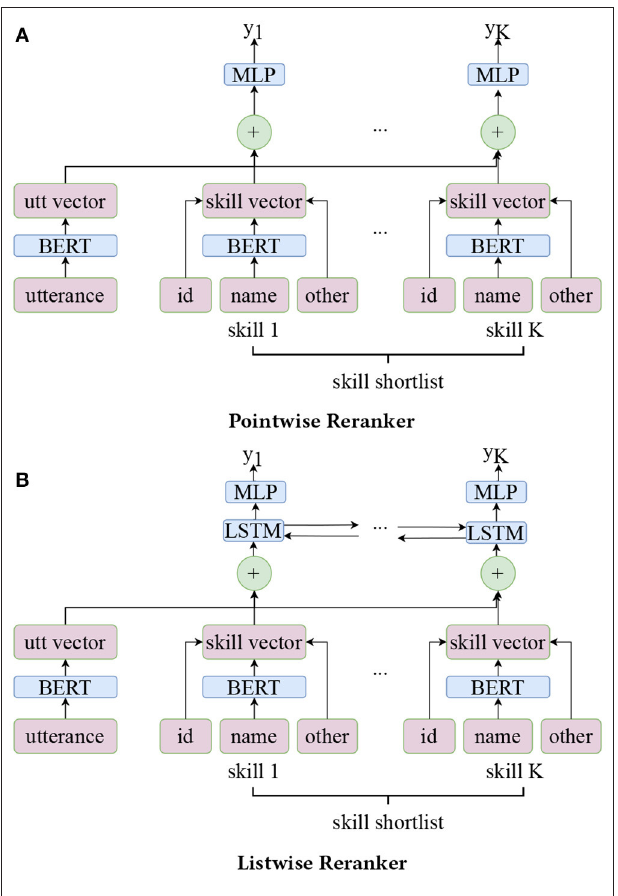
FIGURE 3 | Model architecture of reranker model. (A) Pointwise reranker. (B) Listwise